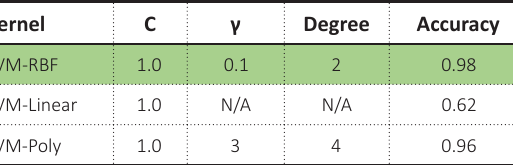
Table 5. Parameters of the selected kernels